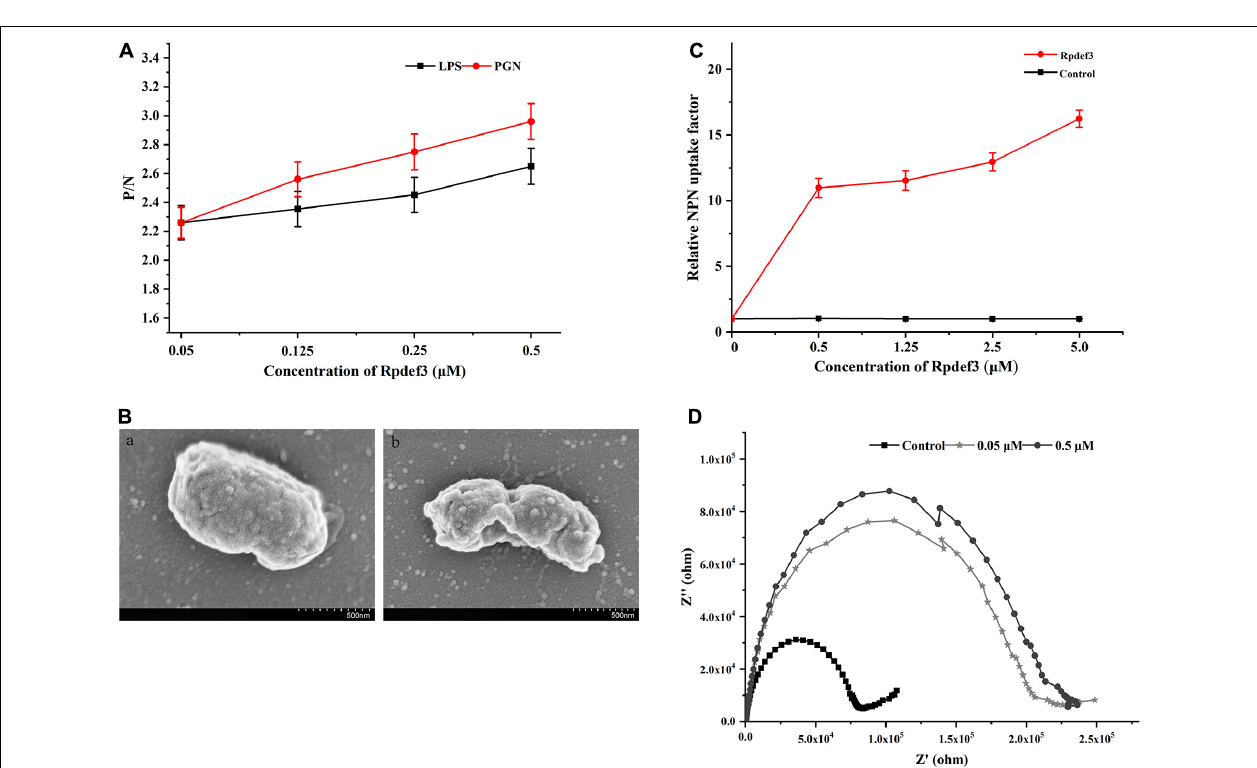
FIGURE 5 | Antibacterial mechanism of Rpdef3. (A) ELISA assay of the interaction between Rpdef3 and PAMPs. Plates were coated with four kinds of PAMPs including LPS and PGN, and then incubated with different amounts of Rpdef3. After incubated with Rpdef3 antibody and goat-anti-mouse Ig-alkaline phosphatase conjugate, the absorbance was recorded at 405 nm. Samples with P/N > 2.1 were considered positive. Results were representative of the mean of three replicates ± S.D. (B) Membrane permeabilization of E. coli caused by Rpdef3. Each group had three replicates. (C) SEM images of E. coli in the absence (a) or presence (b) of Rpdef3 (0.5 µ M) after exposure for 1 h. (D) Impedance complex plane plots of s-BLMs coated gold electrode in the presence of Rpdef3. EIS was carried out over a frequency range of 0.01 Hz–100 kHz at a signal amplitude of 10